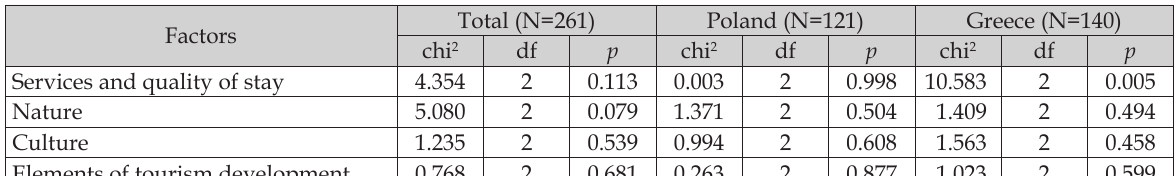
Table 7. Statistical analysis, using the kruskal Wallis test, by respondent group and by country, for the total respondent sample